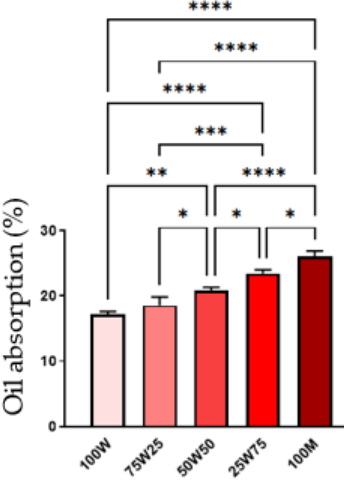
Figure 2 . Cooking loss of batter-coated shrimp with MPBP. 100W: 100% wheat flour, 75W25: 75% wheat flour and 25% MPBP, 50W50: 50% wheat flour and 50% MPBP, 25W75: 25% wheat flour and 75% MPBP, 100M: 100. The error bars indicate standard division. ** p < 0.005, *** p < 0.0005, **** p < 0.00005.